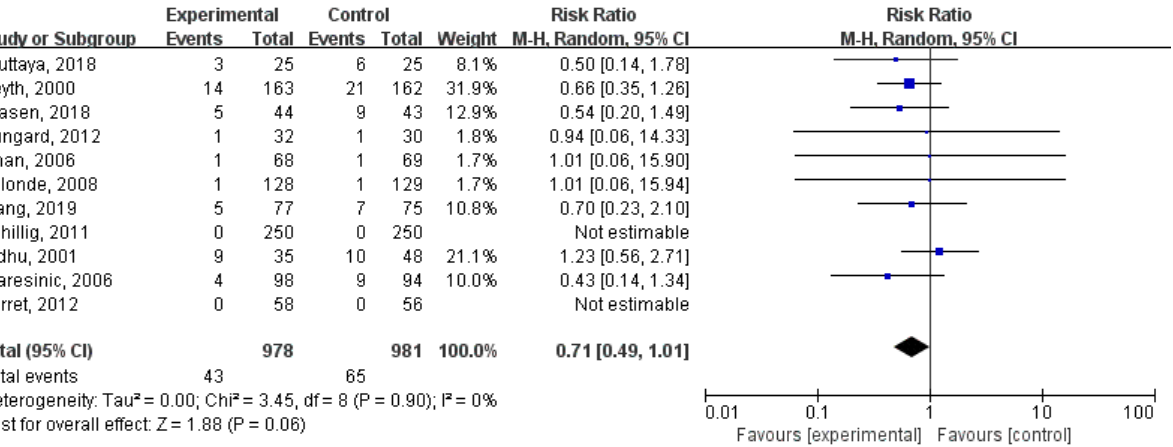
Figure 5. Results of a meta-analysis of the effects of technology-based interventions on thromboembolism events in oral anticoagulation management. M-H: Mantel-Haenszel method. Random: random effect model.